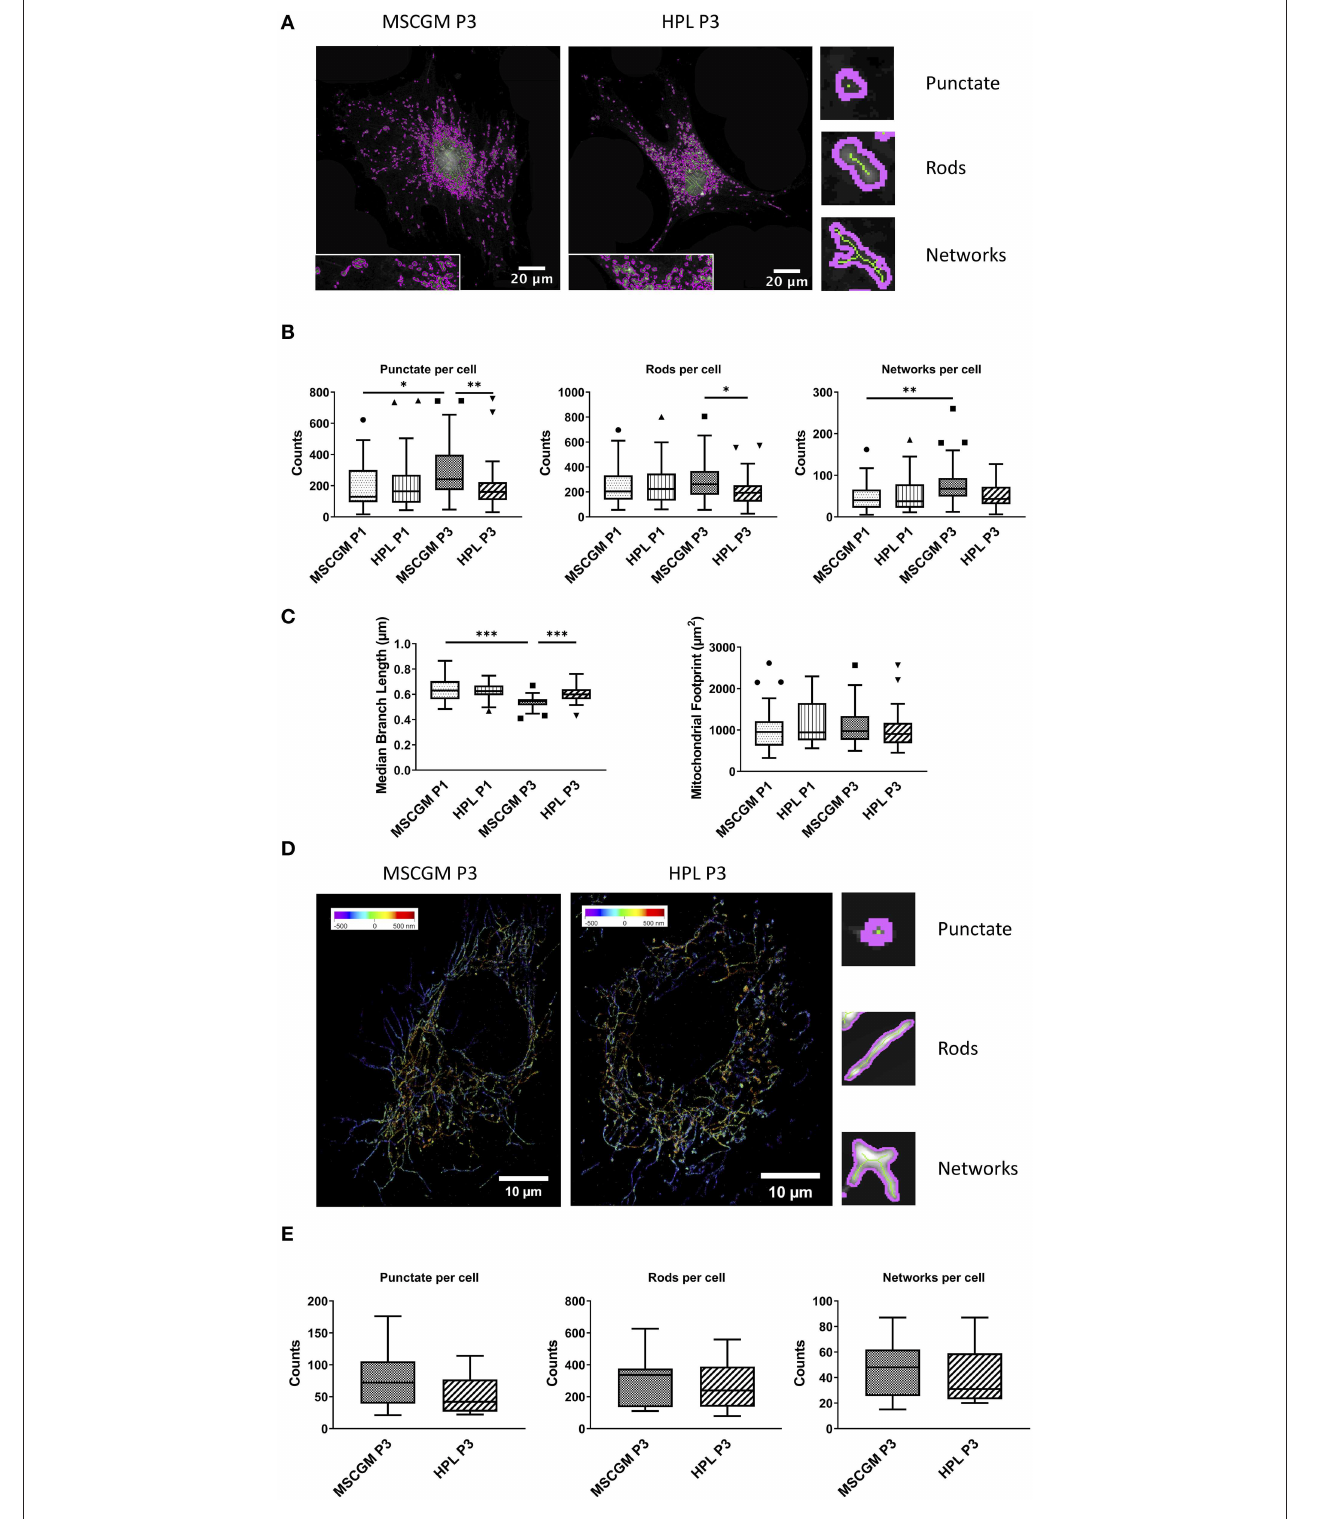
FIGURE 4 | Mitochondrial pattern analysis and super-resolution imaging. (A) Images of Mitochondrial Network Analysis (MiNA) from passage 3 MSCs cultured in MSCGM TM or MSCBM TM with 8% HPL stained with MitoTracker TM (B) Top: Numbers of punctate mitochondrial organelles per cell compared in different media